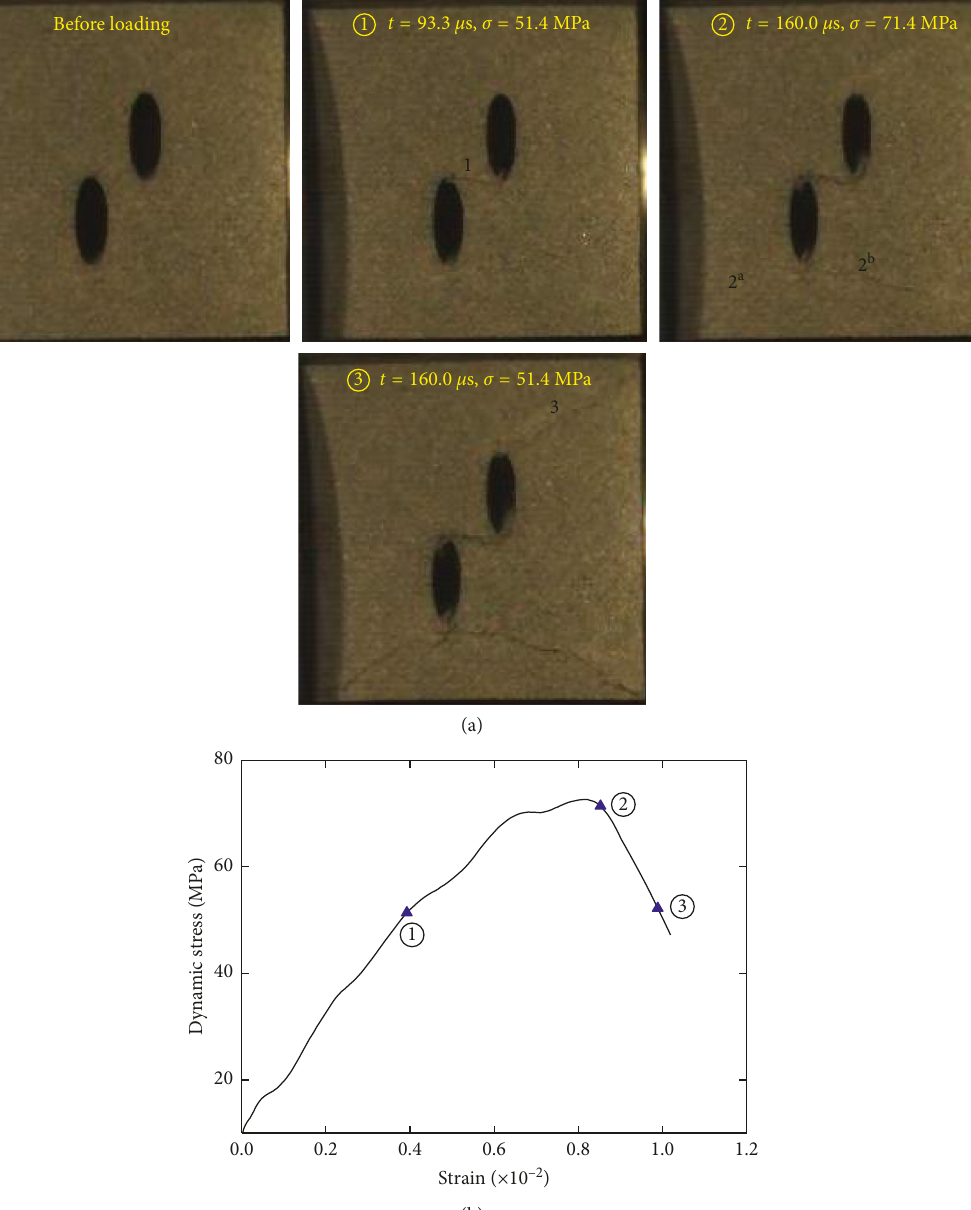
Figure 18: Fracturing process of type III mode with its corresponding dynamic stress-strain curve ( α